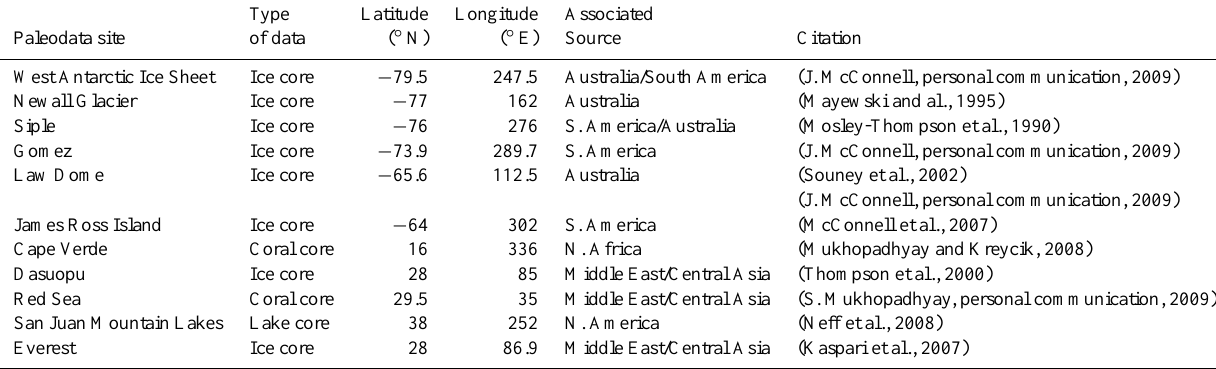
Table 1. The location of the paleodata sites and associated source used to infer the 20th century dust trends.